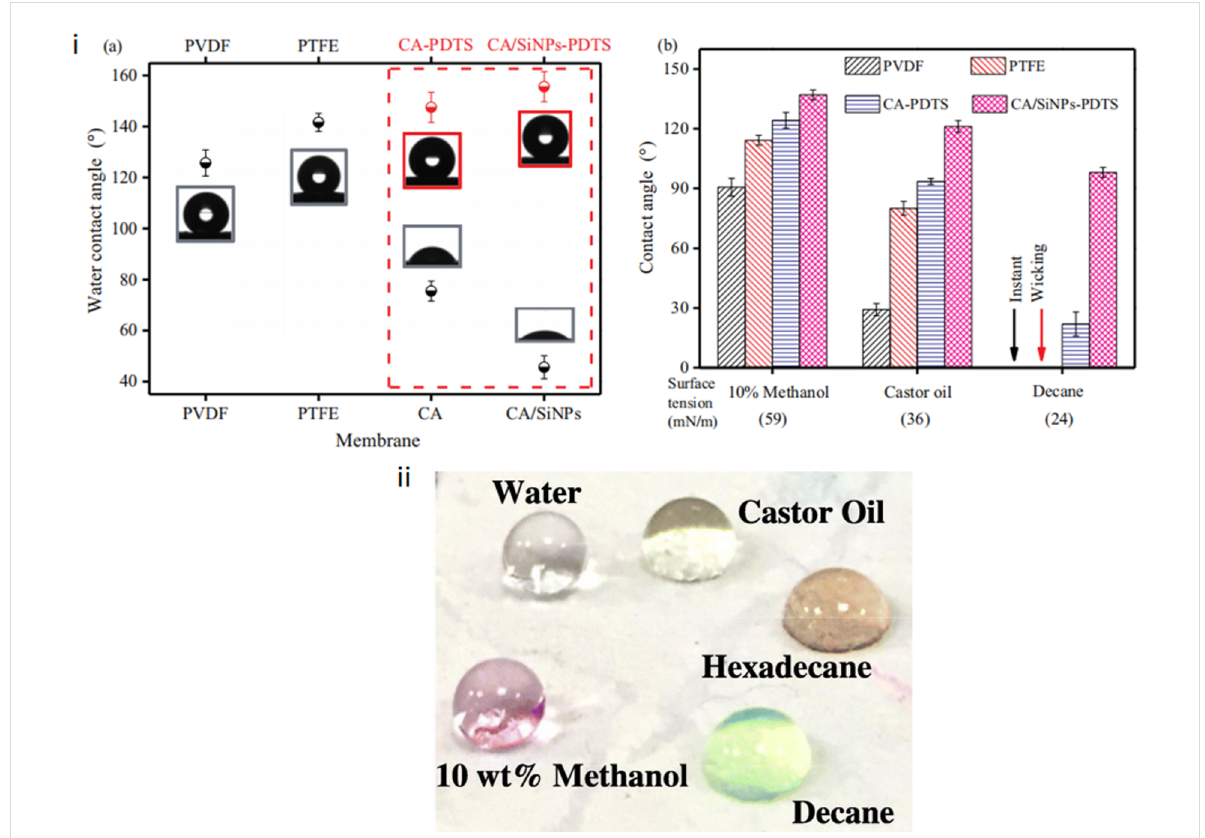
Figure 7: (i) (a) Water contact angles of the commercial PVDF and PTFE hydrophobic membranes and the fabricated fibrous membranes; (b) com- parison of contact angles among the commercial PVDF and PTFE hydrophobic membranes and the fabricated fibrous membranes with different liquids. (ii) Photos of different liquids on the omniphobic membrane. Figure 7 was reprinted from [125], Desalination, vol. 468, by D. Hou; C. Ding; C. Fu; D. Wang; C. Zhao; J. Wang, “Electrospun nanofibrous omniphobic membrane for anti-surfactant-wetting membrane distillation desalination”, article no. 114068, Copyright (2019), with permission from Elsevier. This content is not subject to CC BY 4.0.